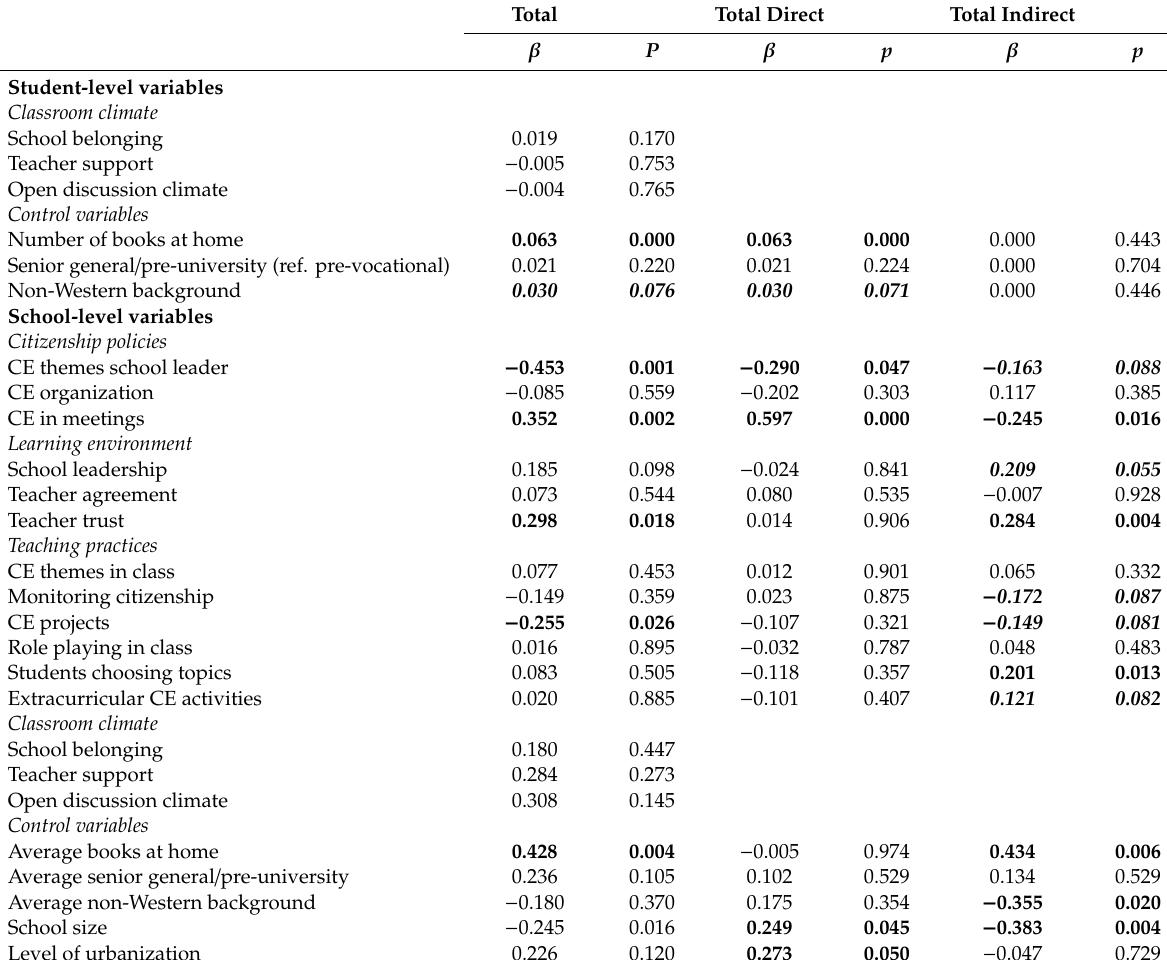
Table 5. Total, direct and indirect e ff ects on citizenship skills (standardized